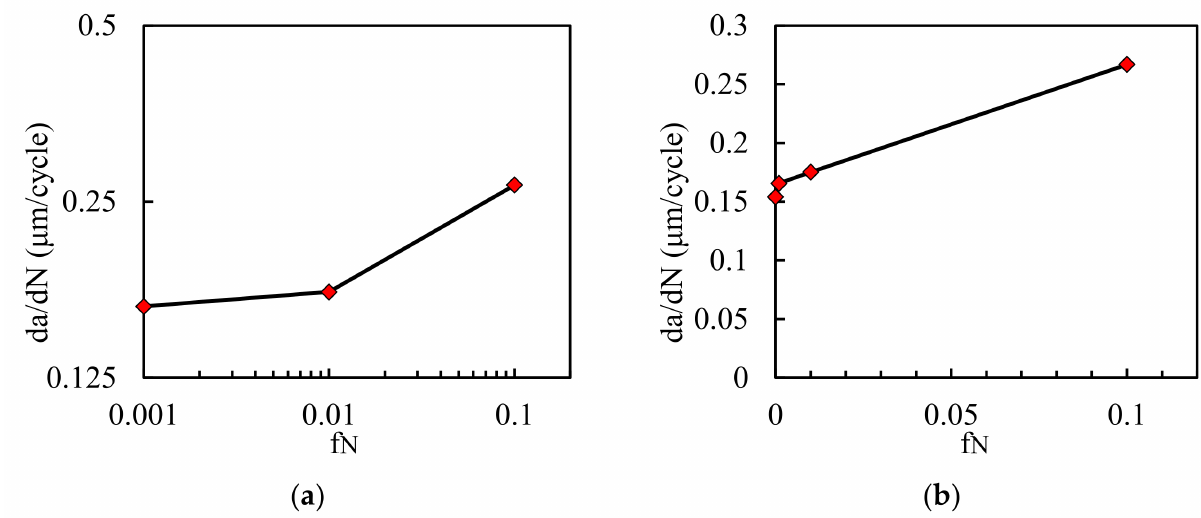
Figure 13. da/dN in terms of f N , for an initial crack length of 11.5 mm in: ( a ) log-log scales; ( b ) natural scales. Coalescence is disabled, (q 1 = 1.5, q 2 = 1, q 3 = 2.2 5, f 0 = 0.01, ε N = 0.25 and s N =